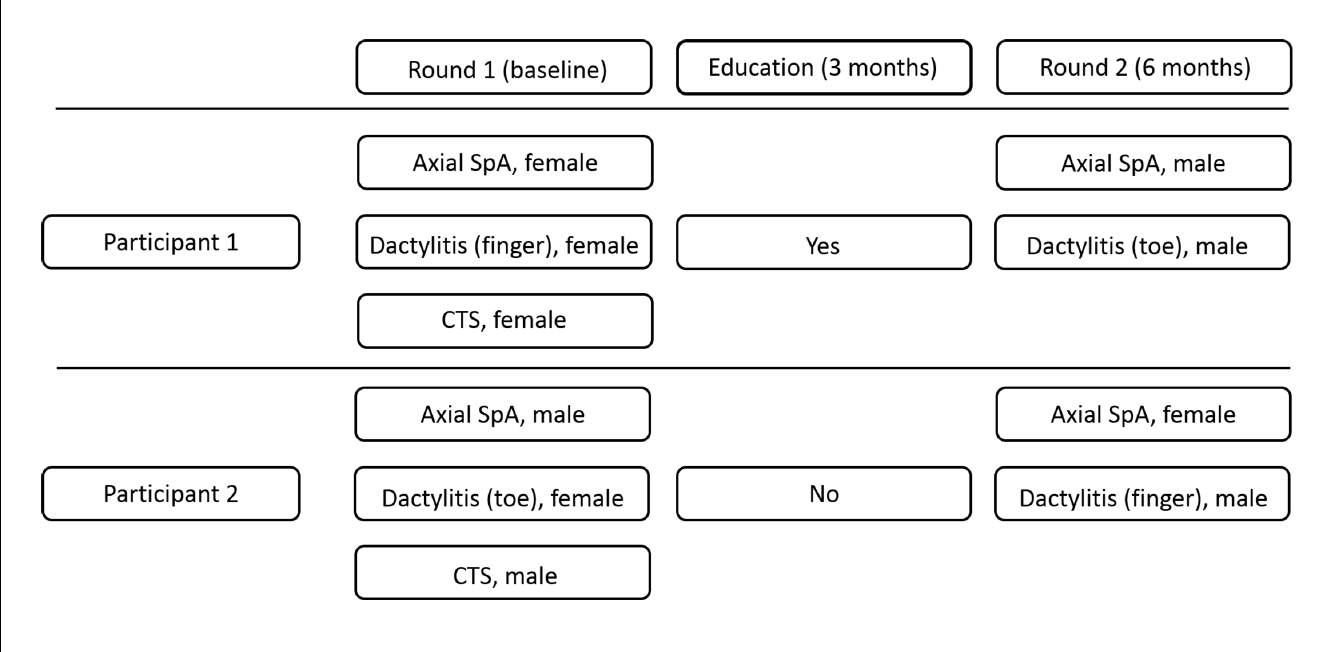
Figure 1. Example of a predefined schedule for 2 participants. CTS = carpal tunnel syndrome. SpA = spondyloarthritis.